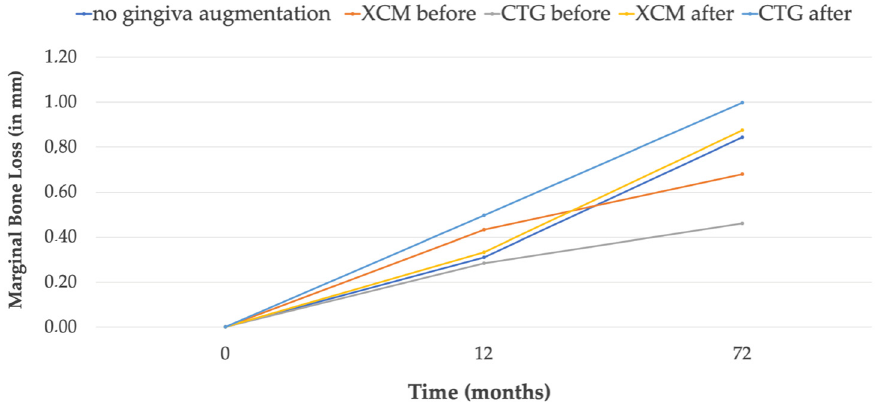
Figure 4. MBL change in individual groups from baseline to 5 years. Simplified chart.